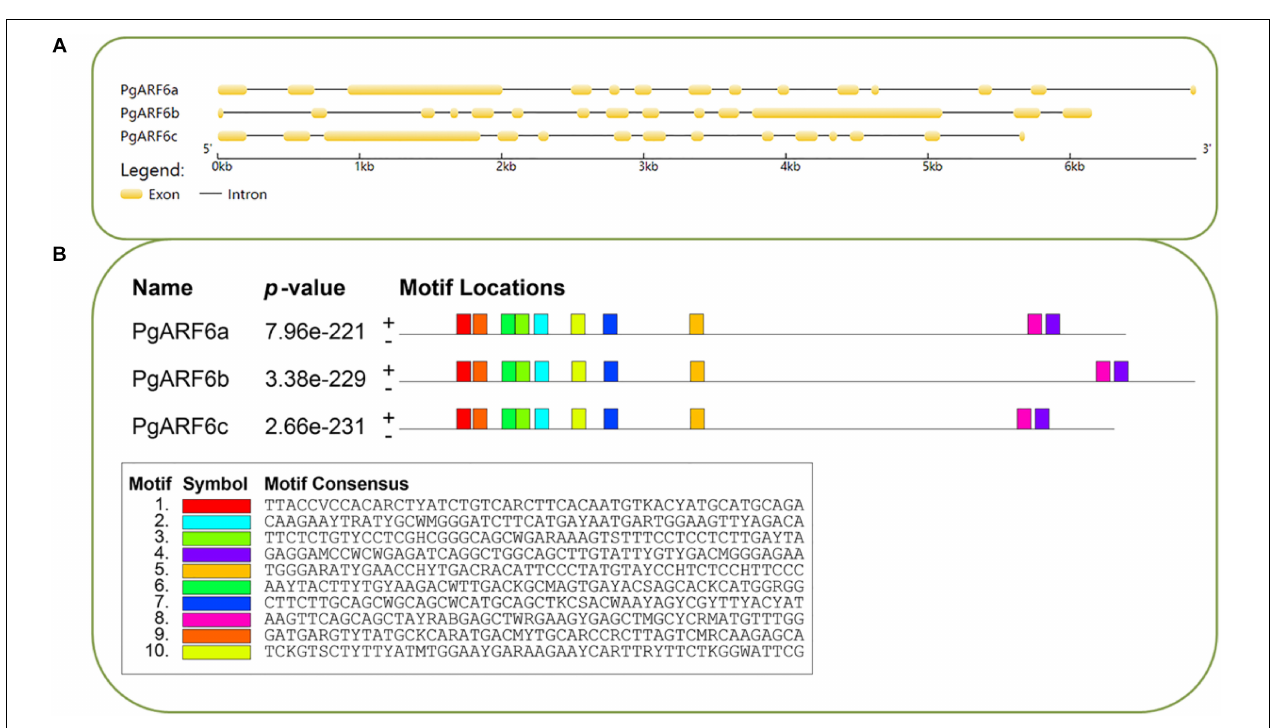
FIGURE 2 | Basic information of PgARF6 sequences in pomegranate. (A) Gene structure of PgARF6s , (B) conservative nucleic acid motifs of PgARF6s .